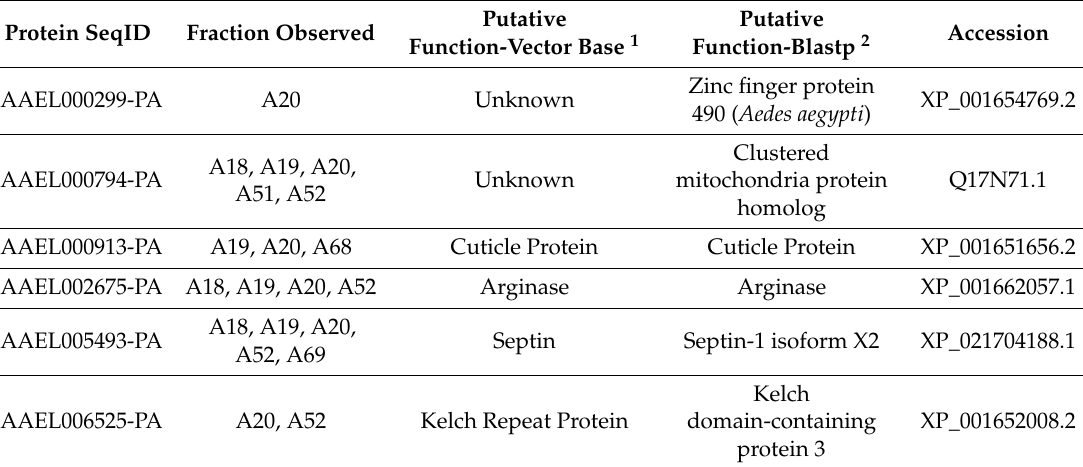
Table 1. Proteins found in the enhancing fractions of mosquito